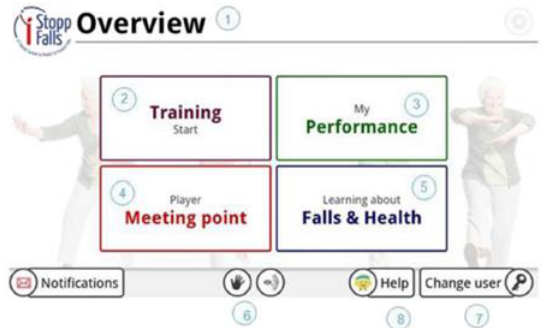
Figure 3. The different menu options available to users in the iStoppFalls ICT-based system.